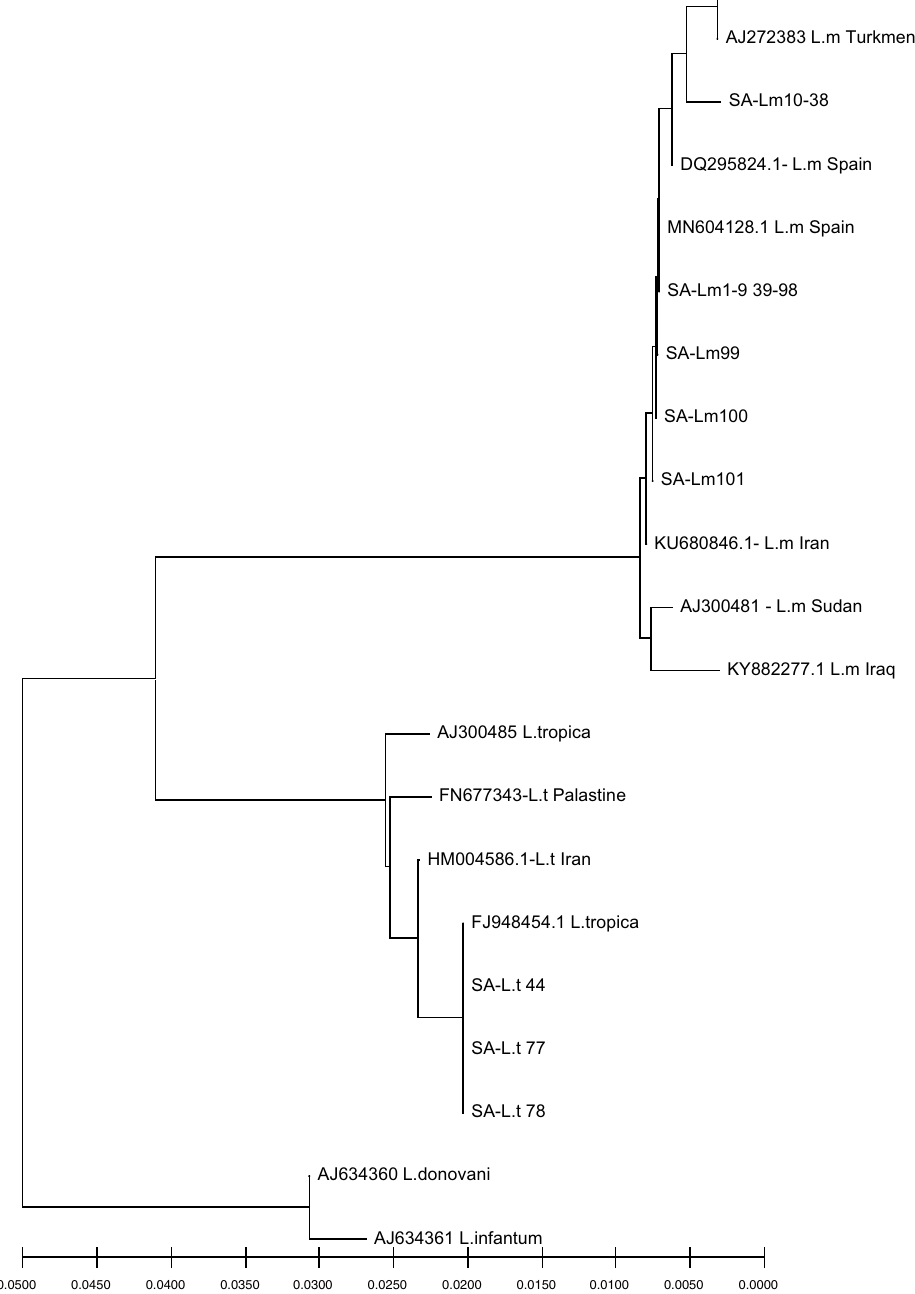
Figure 4. Dendrogram shows the Neighbor-joining phylogenetic tree of L.major (SA-L.m 1–9 and 39–98 in one cluster, 10–38 in one cluster, 99, 100 and 101) and L.tropica (SA-L.t 44, 77 and 78) study isolates relied on ITS1-5.8S rDNA gene sequences in comparison to reference strains (their accession number is located before their names). Similar sequences were clustered in the tree. Bootstrap analysis was relied on 1000 replicates. The distance scale at the bottom of the tree represents the number of differences between the